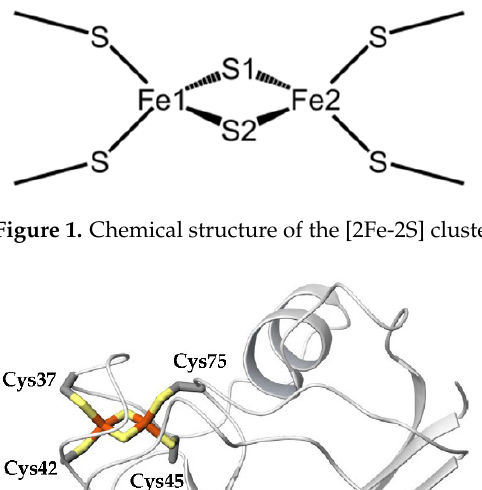
Figure 2. Overall structure of plant-type Fd. [2Fe‒2S] cluster and ligated Cys residues are presented as licorice.